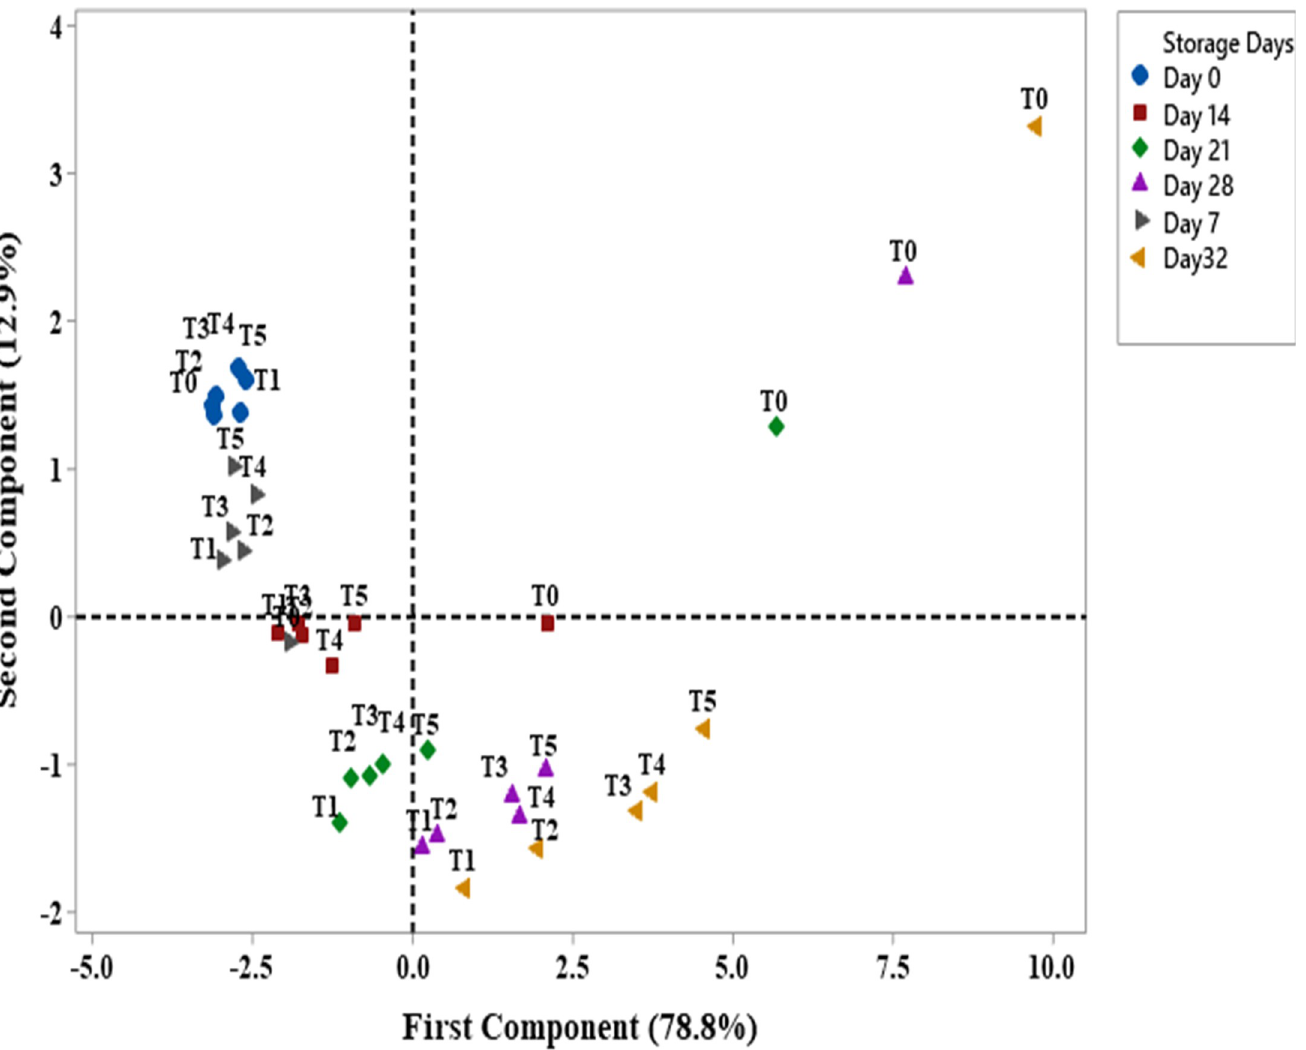
Fig 24. Banana samples scores with various AgNPs concentration (T0 = control, T1 = 0.01%, T2 = 0.02%, T3 = 0.03%, T4 = 0.04%, T5 = 0.05%) in the PCA plane with PC1: 78.8% of total variance and PC2: 12.9% of total variance. Symbols represent the storage days: ‘Day 0’ ( ● ), Day 7 ( ► ), Day 14 ( ■ ), Day 21 ( ♦ ), Day 28 ( ▲ ) and Day 32 ( ◄